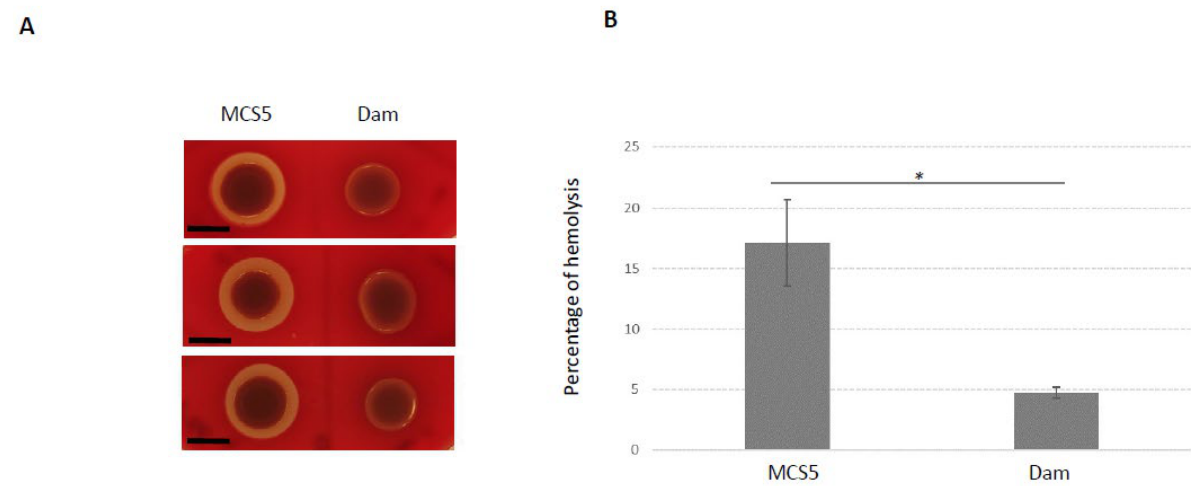
Figure 7. Hemolytic activity produced by X. nematophila F1 overexpressing dam gene (Dam) and control (MCS5). ( A ) Halos of hemolysis were observed on sheep blood agar medium inoculated with 5 µ L of exponentially growing cells (3 independent biological replicates are shown; Black bars, 5 mm). ( B ) Liquid hemolytic assay: the released hemoglobin following lysis of sheep red blood cells was measured for each strain from cells grown 8 h in LB. * Difference between the two strains is significant ( p < 0.05, Student’s t -test).